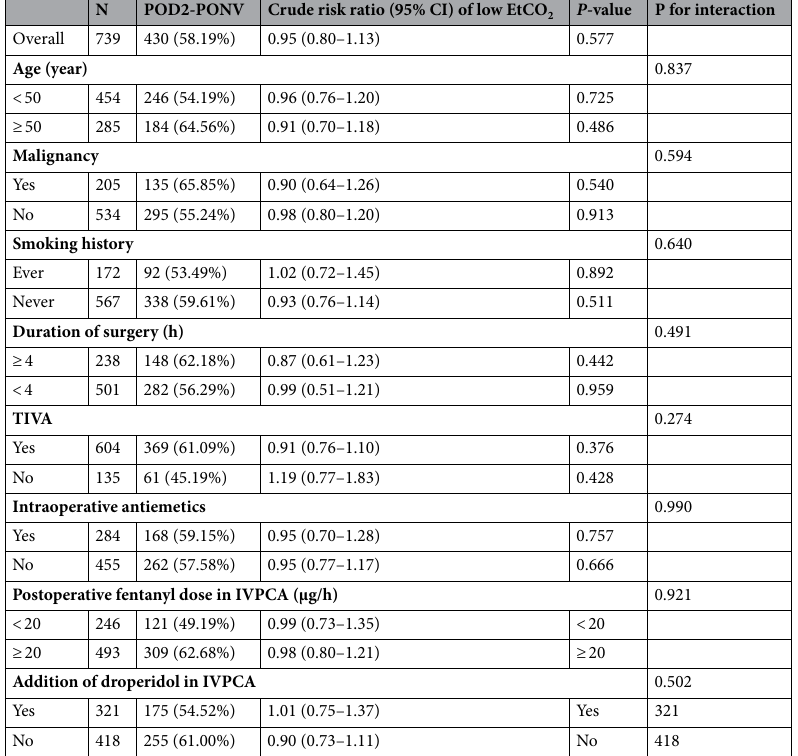
Table 5. Subgroup analyses stratified by patient and operative variable. POD 2 postoperative day 2, PONV postoperative nausea and vomiting, CI confidence interval, TIVA total intravenous anesthesia, IVPCA intravenous patient-controlled